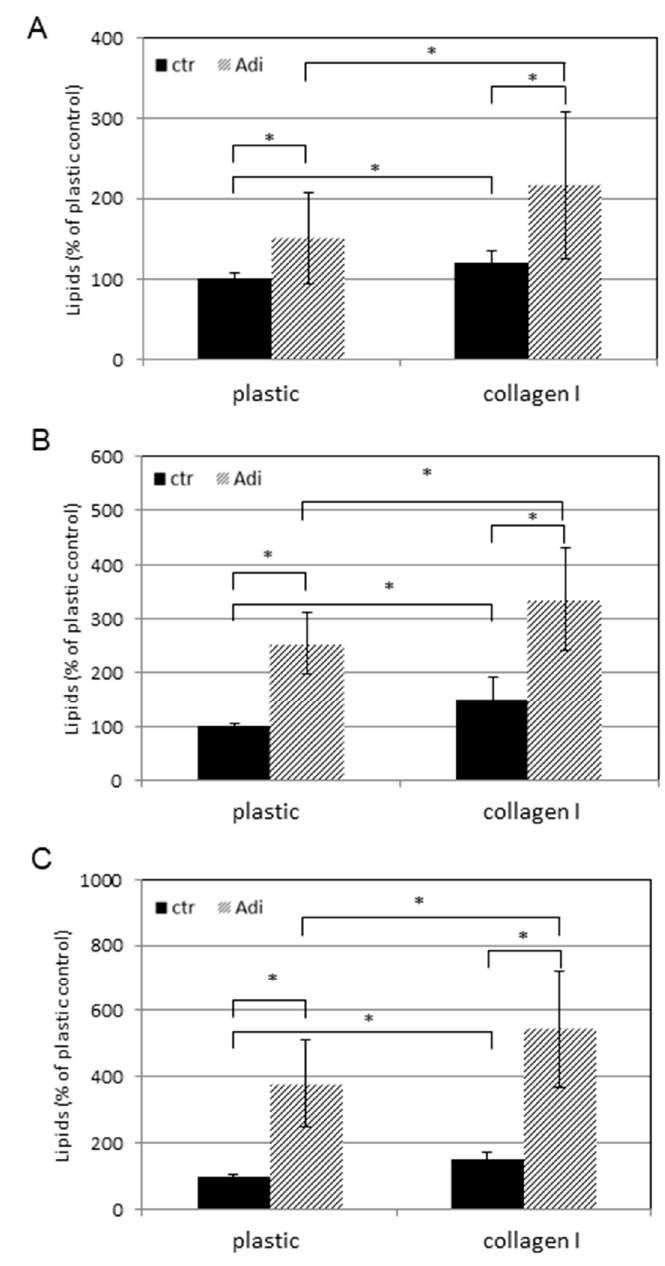
Figure 3. Quantitative lipogenesis of ASCs on plastic or collagen I. ASCs were plated at a density of 1 × 10 4 cells per well into microtiterplates either non-coated (plastic) or coated with collagen I. One part was held in regular DMEM medium (ctr) and the other in adipogenic medium (Adi). After ( A ) 9 days, ( B ) 11 days, and ( C ) 15 days, cells were stained with nile red and bisbenzimide and the fluorescence was measured (see Materials and Methods). Each point represents the mean of 16 independent experiments. The standard deviations are indicated. Data sets were statistically compared as indicated. * p <